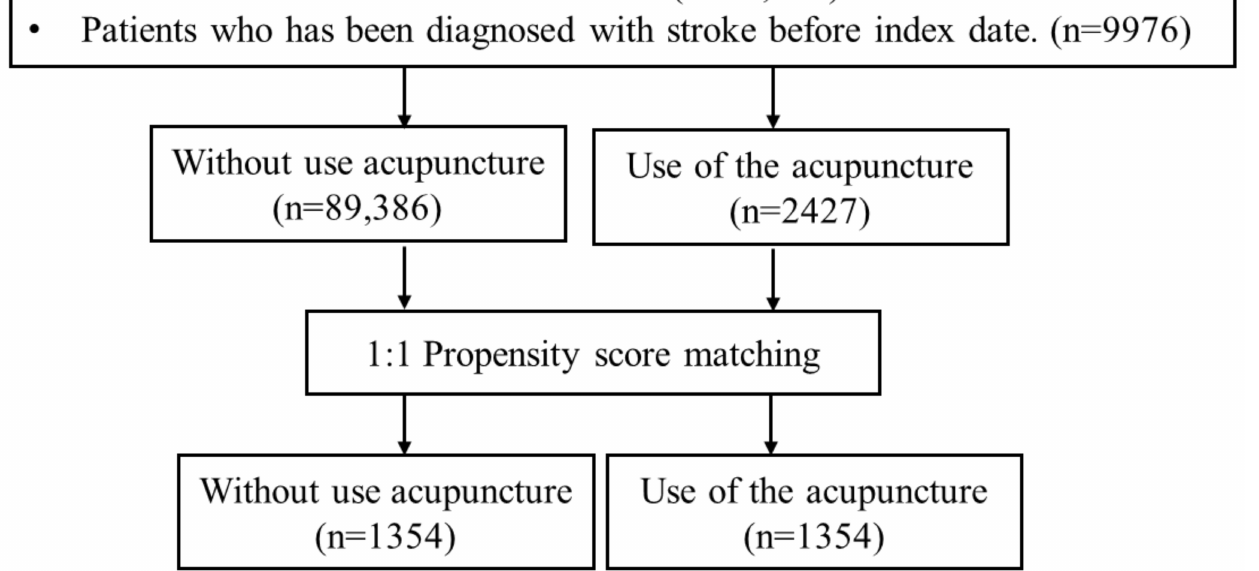
Figure 1. Study flowchart. LGTD 2005: Longitudinal Generation Tracking Database